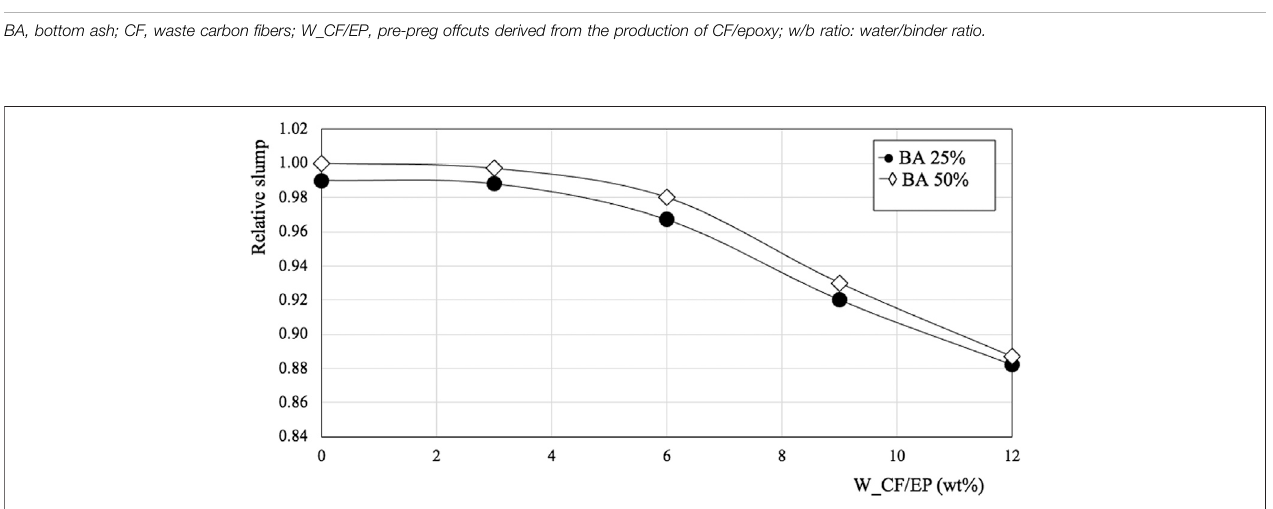
FIGURE 2 | Relative workability of the investigated composites.